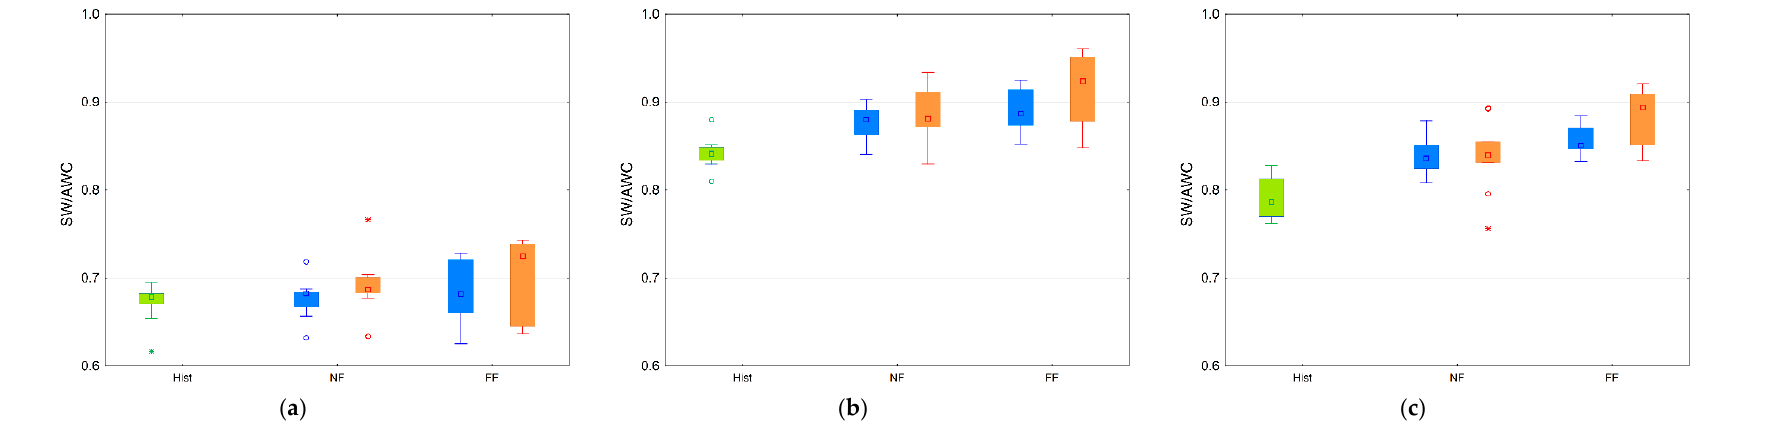
Figure 5. Projected changes of soil water (SW) in relation to available water capacity (AWC) for habitat: ( a ) bog woodland (91D0—bog woodland); ( b ) bog habitats (7110—active raised bog; 7140—transition mires and quaking bogs; 7120—degraded raised bogs still capable of natural regeneration), ( c ) fen habitats (7210—calcareous fens with Cladium mariscus and a species of the Caricion davallianae , 7230—alkaline fens) in RCP 4.5 (blue), 8.5 (orange), and the baseline scenario (green).